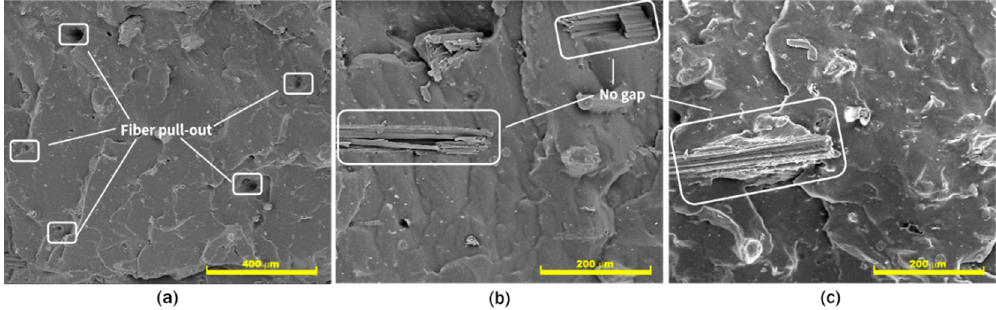
Figure 6. FE-SEM images of fractural cross-section on NR/NF composite added NR-g-St with ( a ) 0 phr at 100 × magnification, ( b ) 1 phr, and ( c ) 2 phr, both at 500 × magnification.